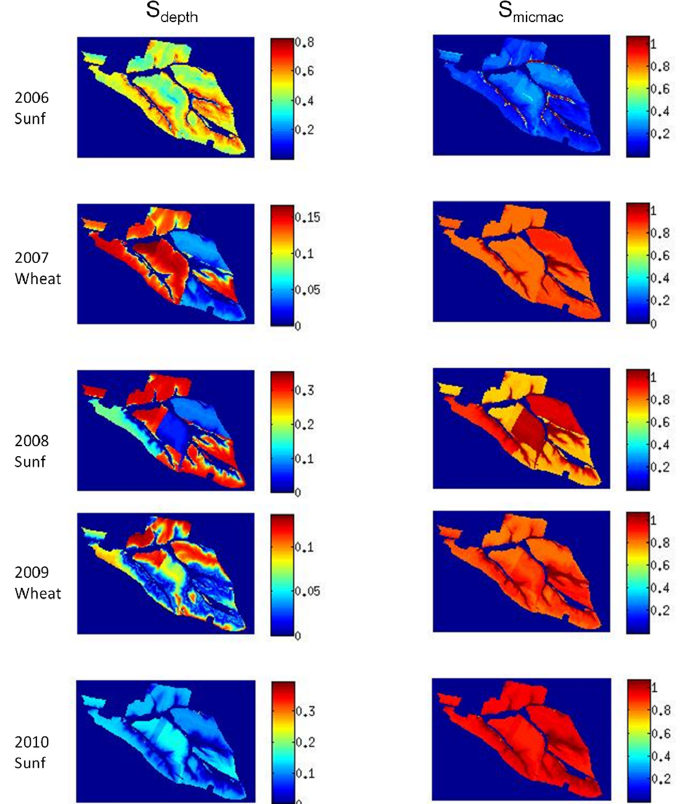
Figure 4. Sobol indices of each sensitivity surfaces of LAX for each pixel and each year (line). S depth and S micmac (respectively, Equations (1) and (2)) represent the sobol sensitivity of LAX to the soil depth parameter ( depth , first column) and S micmac the sensitivity to the retention porosity parameter ( micmac , micro–macro porosity ratio). The higher the value is, the higher the sensitivity is.